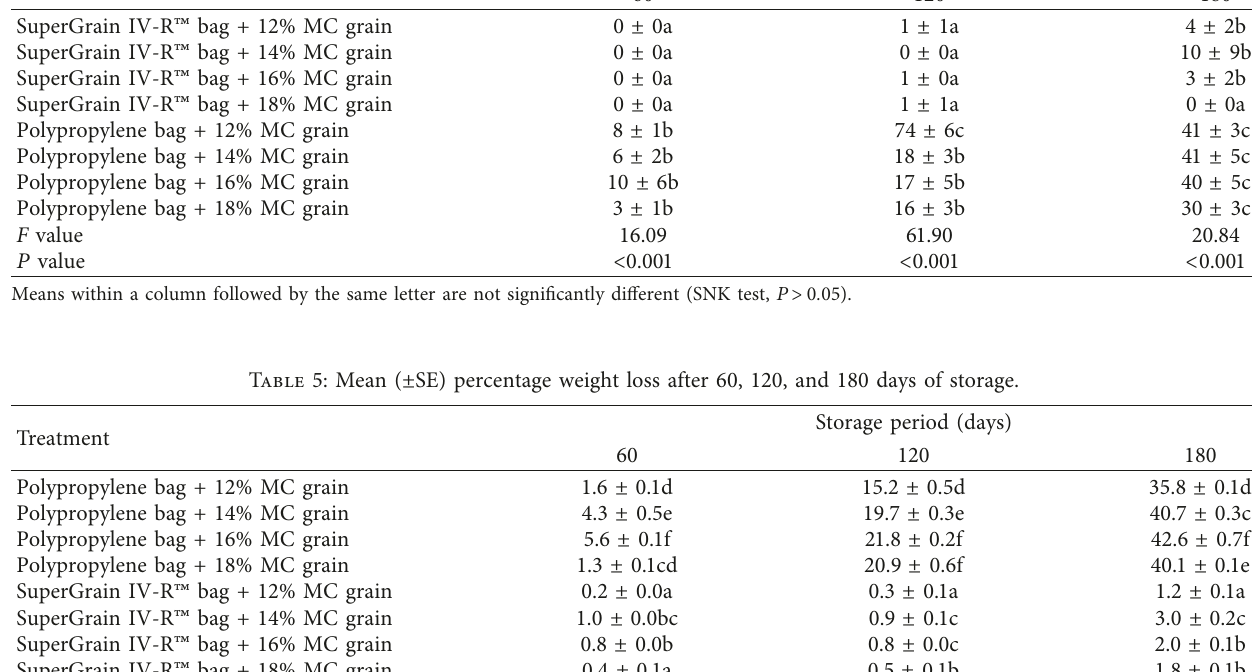
Table 4: Mean ( ± SE) number of adult Prostephanus truncatus per kilogram of grain after 60, 120, and 180days of storage. Treatment